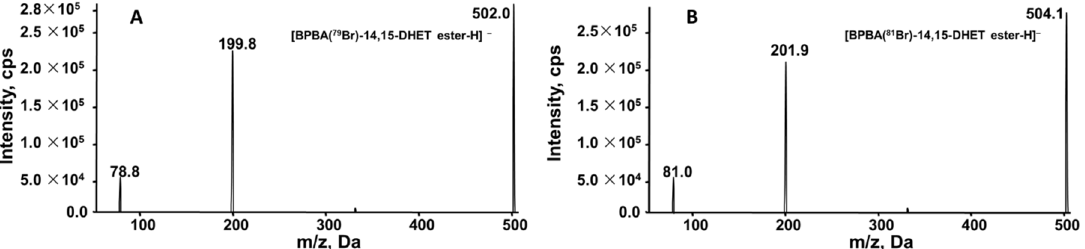
Figure 2. Tandem mass spectra of BPBA labeled 14,15-DiHETrE. ( A ) BPBA ( 79 Br) 14,15-DiHETrE ester; ( B ) BPBA ( 81 Br) 14,15-DiHETrE ester.